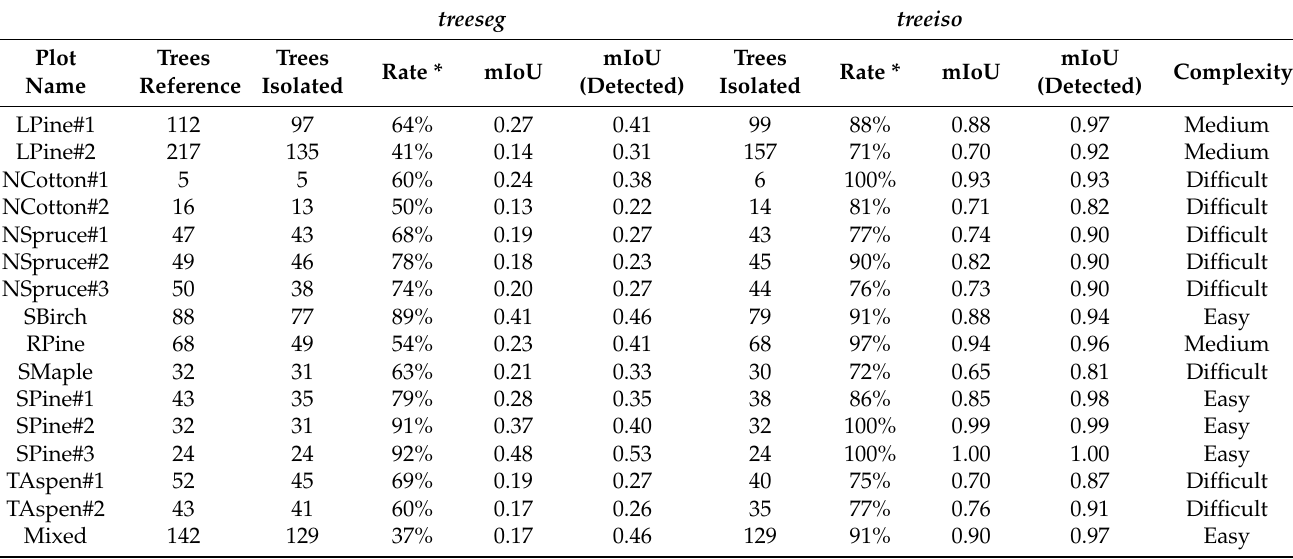
Table 3. Accuracy of plot tree detection and isolation. treeseg